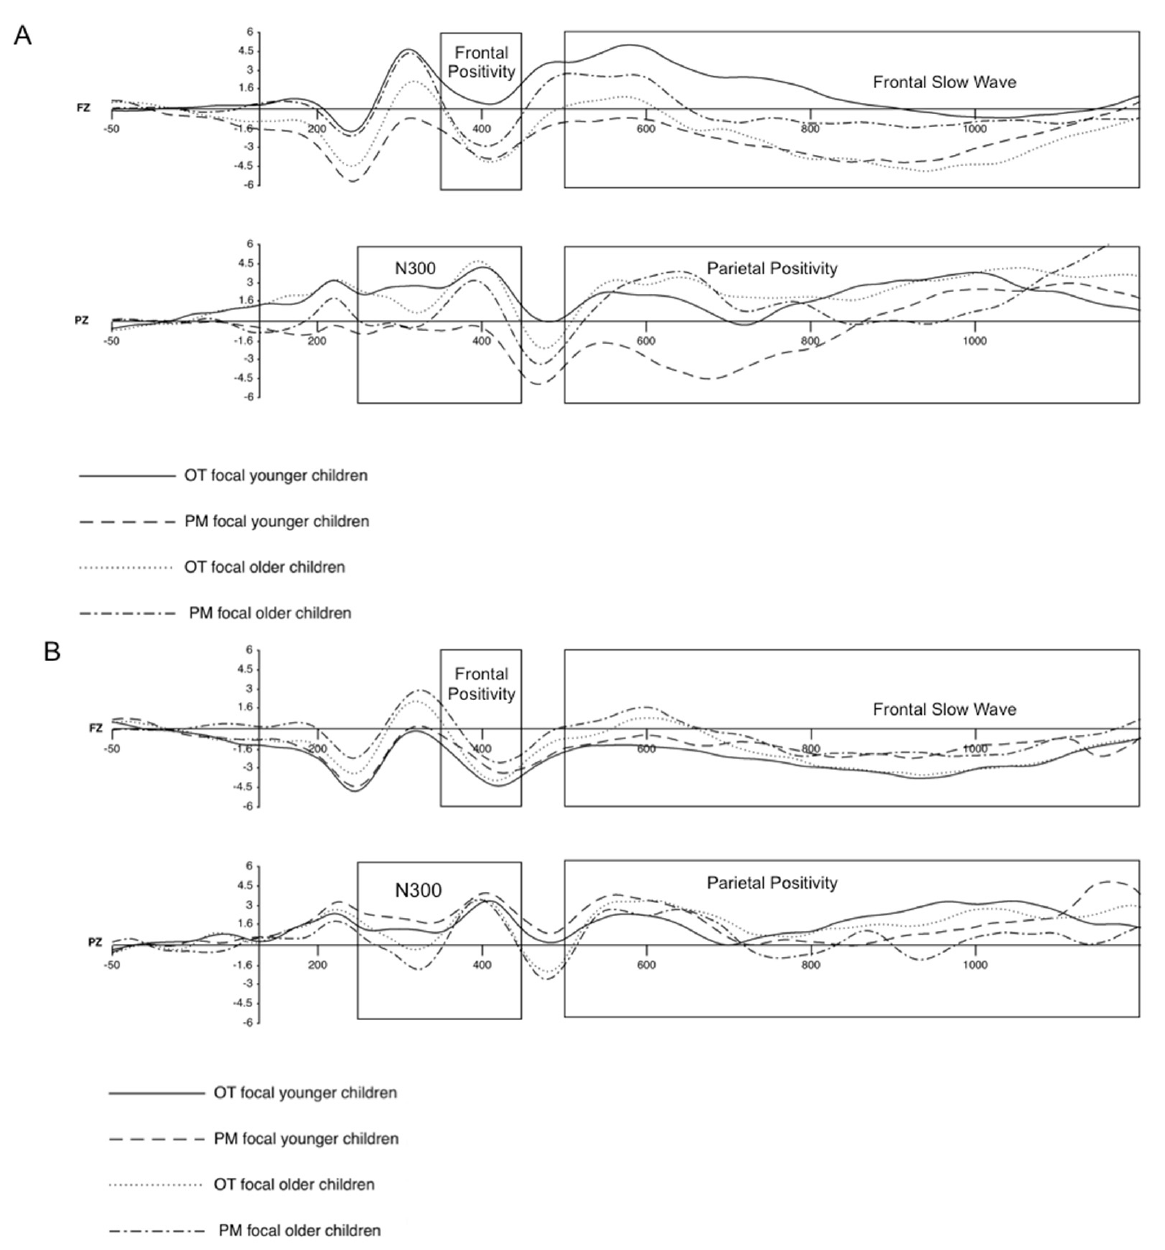
Figure 4. Grand-averaged event-related brain potentials at FZ and PZ electrodes used in the ANOVAs demonstrating frontal positivity, frontal slow waves, N300 and parietal positivity as a function of type of task trial (OT vs. PM) and age group (younger vs older children). ( A ) Grand-average event-related potentials (ERPs) in the focal condition. ( B ) Grand-averaged ERPs in the non-focal condition.